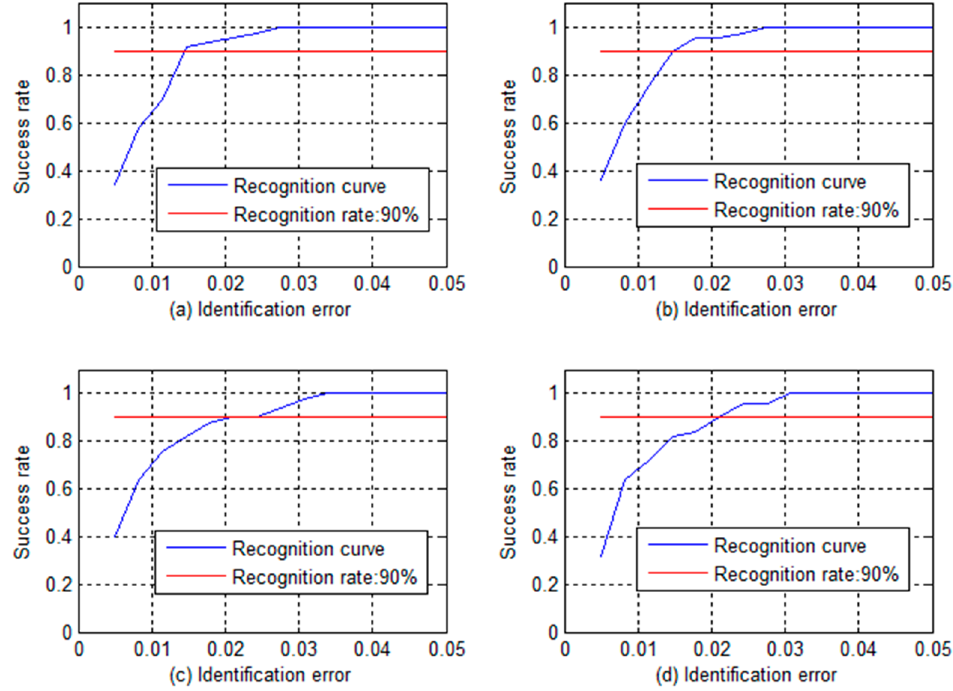
Figure 10. Different hidden nodes recognition graphs: ( a ) Identification ratio graph of 21 hidden layer nodes; ( b ) Identification ratio graph of 24 hidden layer nodes; ( c ) Identification ratio graph of 27 hidden layer nodes; and ( d ) Identification ratio graph of 30 hidden layer nodes.